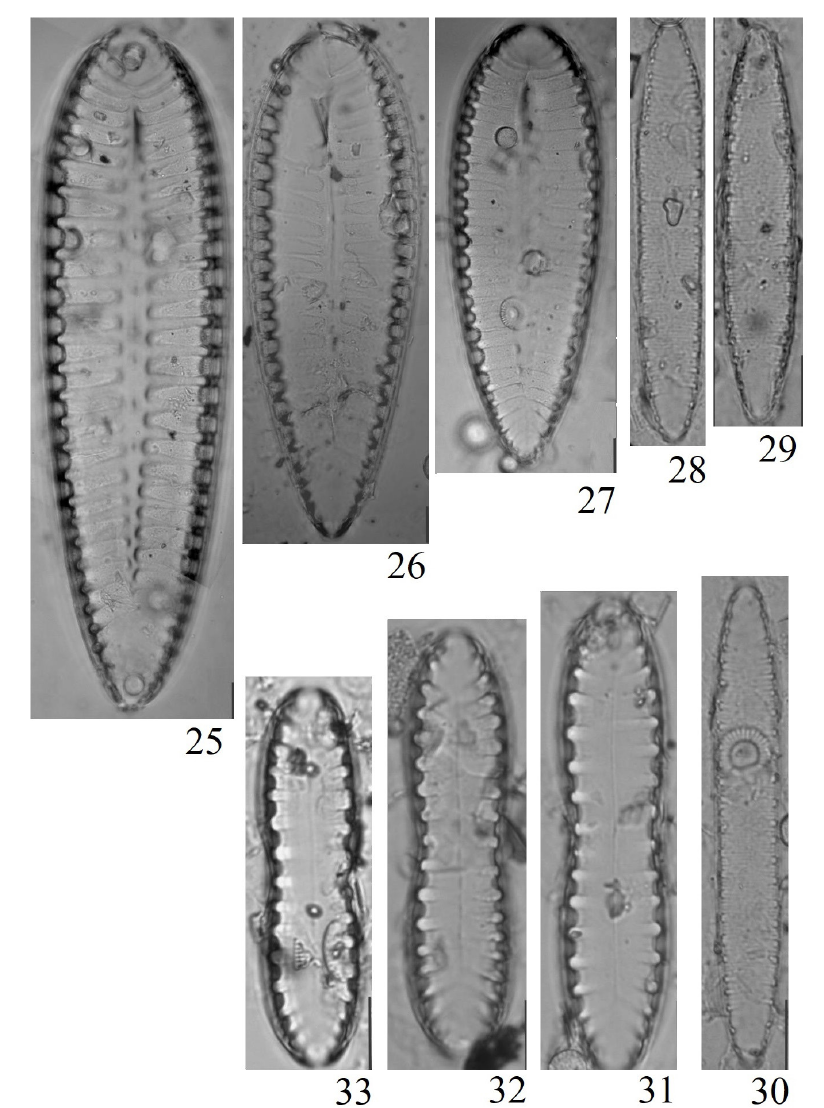
Figures 25-33. Surirellales from surface sediments, São Paulo state. Brazil. Scale bar: 10 µm. 25-27. Surirella splendida . 28-30. Surirella sp. 1. 31-33. Surirella linearis var. constricta